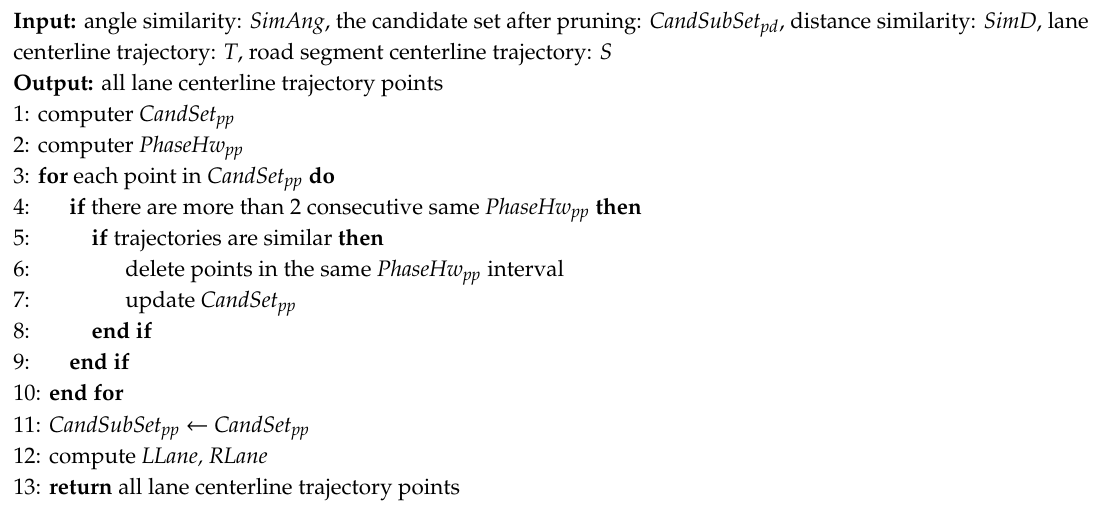
Algorithm 3 Validation, Refinement, and